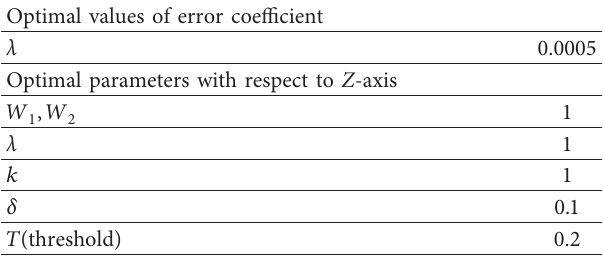
Figure 4: The minimum base station selection strategy. Table 1: Simulation parameters. Table 3: Target 3D location results for Test data